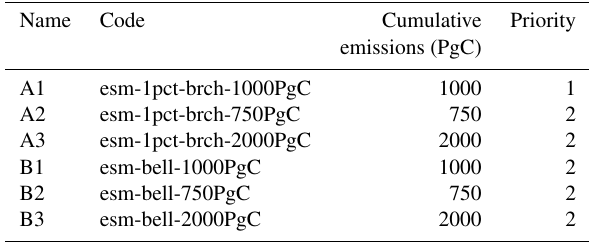
Table 1. Experiments designed for